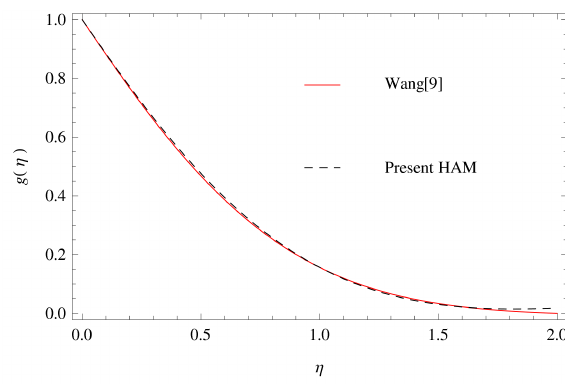
Fig. 19: The influence of a parameter λ on h ( η ) for α = 0.1, We = 0.6, M = 0.03, f = 0.01 and (cid:126) = −0.1 w